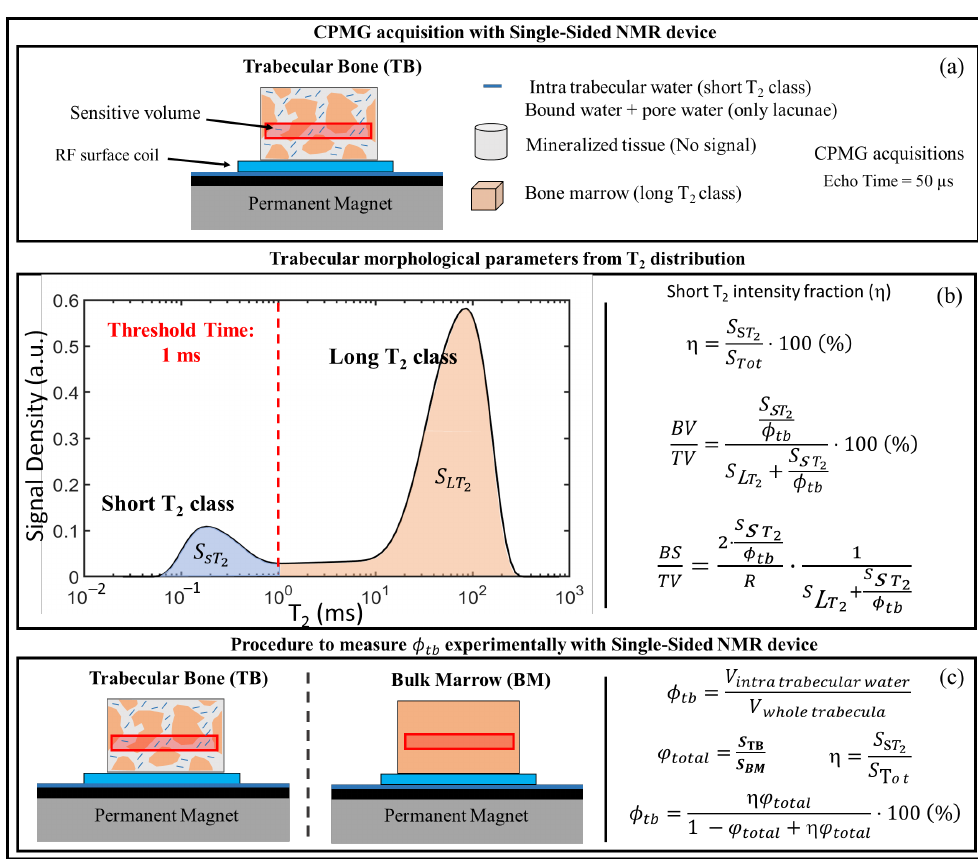
Figure 6. Sketch of the pipeline used in laboratory to evaluate the structural parameters of animal trabecular bone samples in [50]. ( a ) Experimental set-up; ( b ) separation on the T 2 distribution of the signal from 1 H inside the trabeculae from that coming from the marrow within the inter- trabecular spaces, through the definition of a threshold time, set at 1 ms. On the right, the theoretical relationships to estimate the two parameters BV/TV and BS/TS are summarized, starting from the computation of η , i.e., the ratio of the short T 2 signal to the total signal under the T 2 distribution. R is the average radius of the trabeculae, estimated from the average trabecular thickness, measured with micro-CT; ( c ) experimental procedure to measure the total porosity and the intra-trabecular